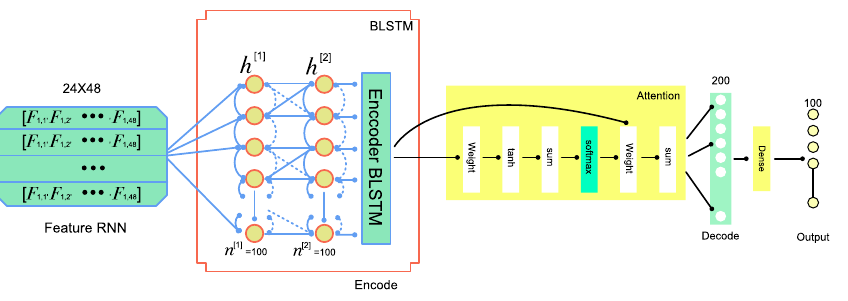
Figure 8. Attn BLSTM module structure.